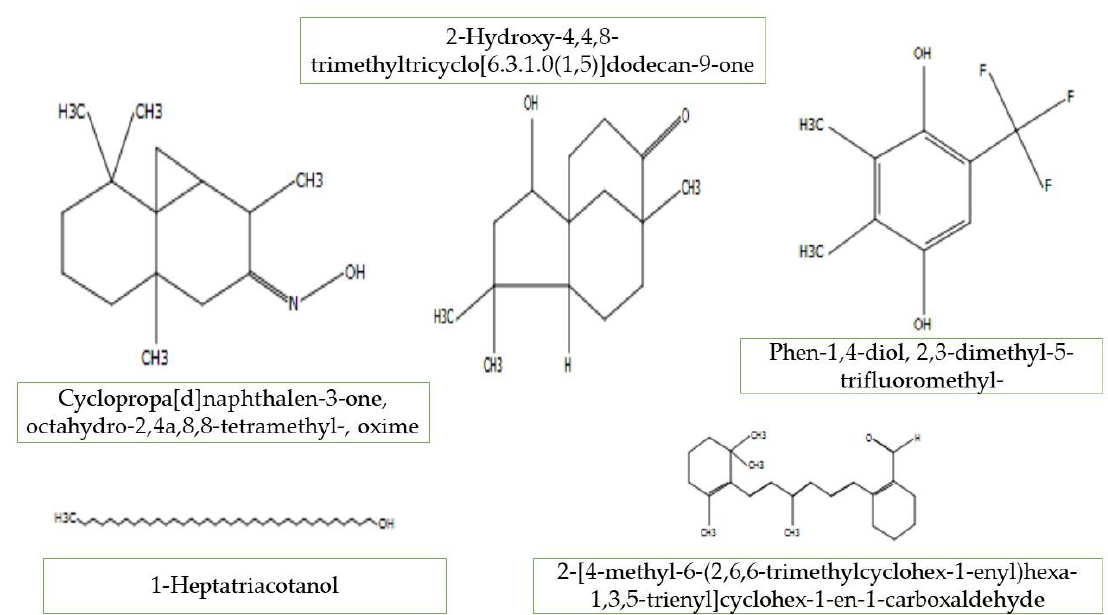
Figure 3. The chemical structures of GC-MS detected compounds in both fruit and petiole. Table 3. List of compounds from ethanolic petiole and fruit extracts observed in GC-MS with their retention time and biological activity.